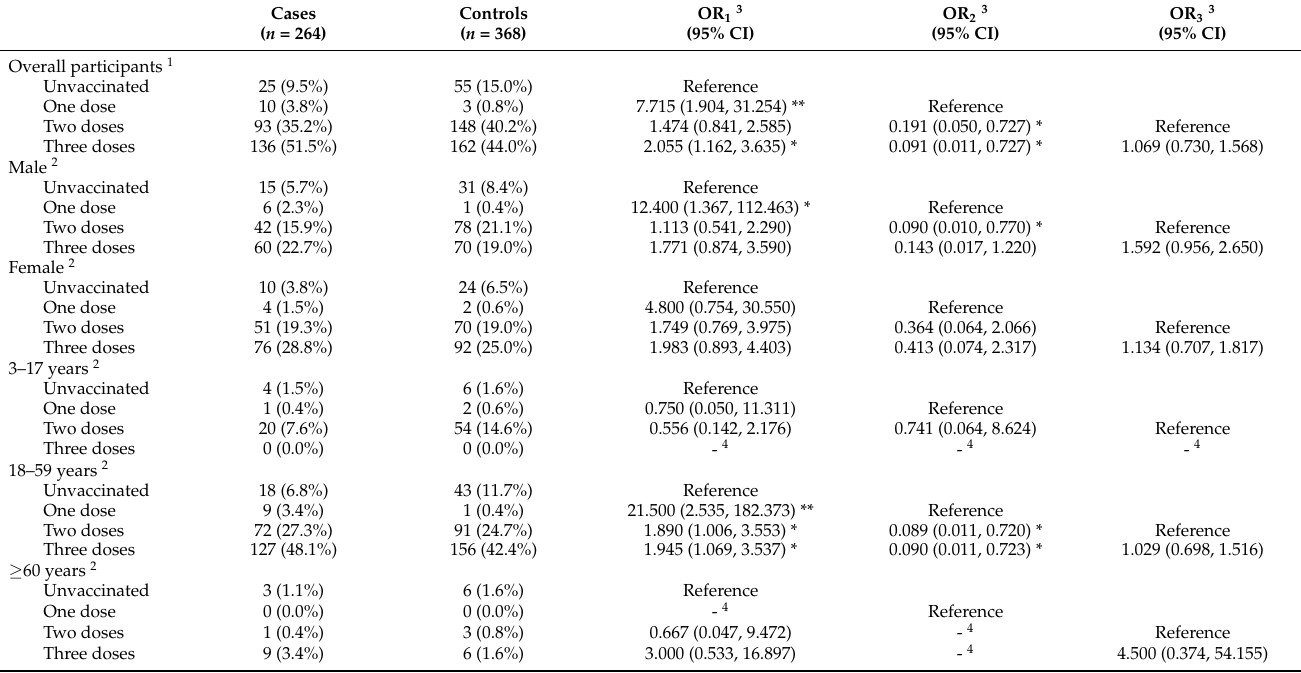
Table 4. Vaccination status of inactivated COVID-19 vaccines compared in cases and controls against Omicron BA.2 infection in